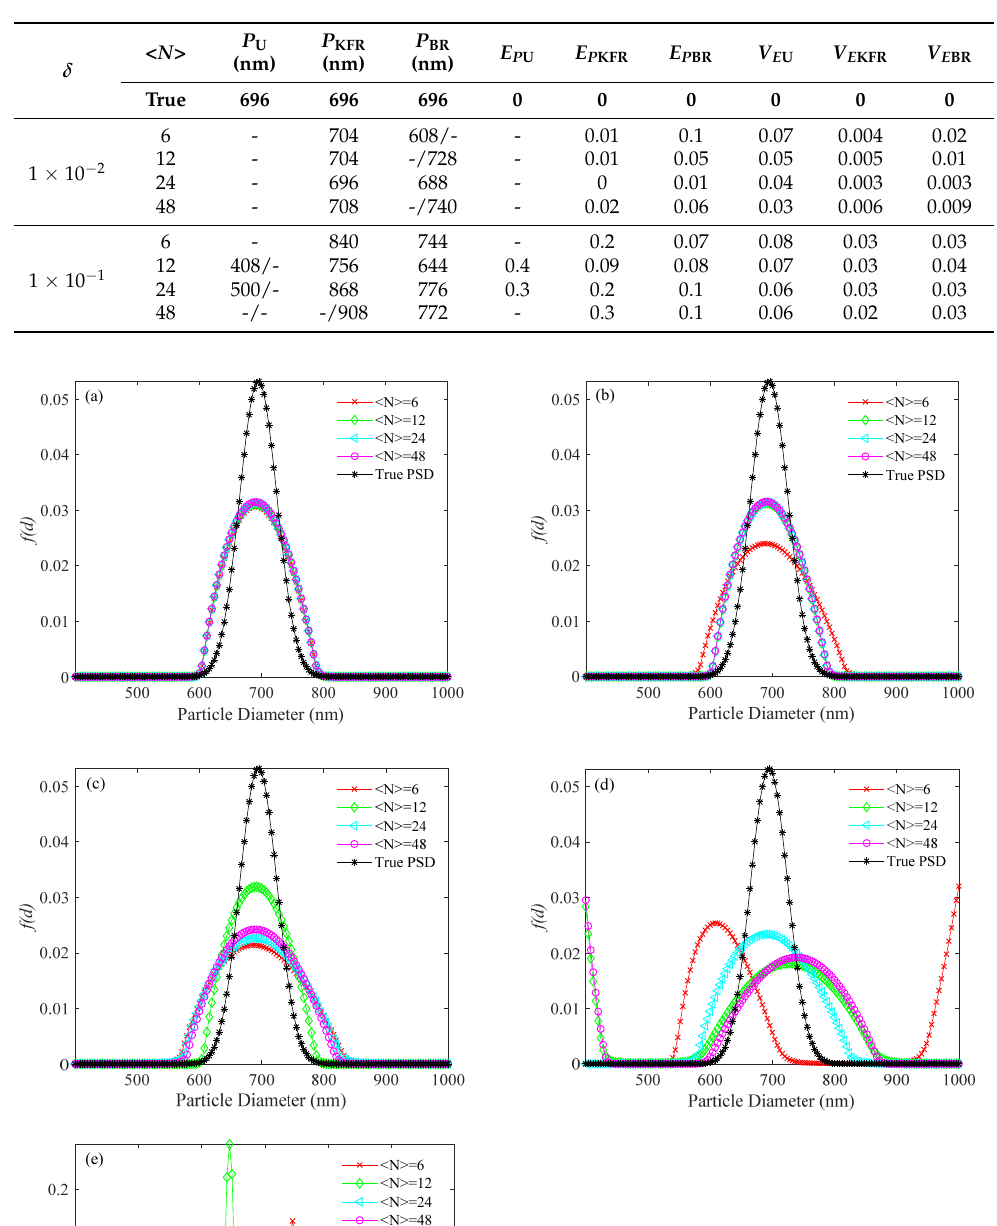
Figure 8. PSD recovered by the KFR method for a 696 nm unimodal sample at number concentrations of < N > = 6, 12, 24, 48, and different levels of noise. ( a ) 0, ( b ) 10 − 4 , ( c ) 10 − 3 , ( d ) 10 − 2 , and ( e ) 10 − 1 noise levels.